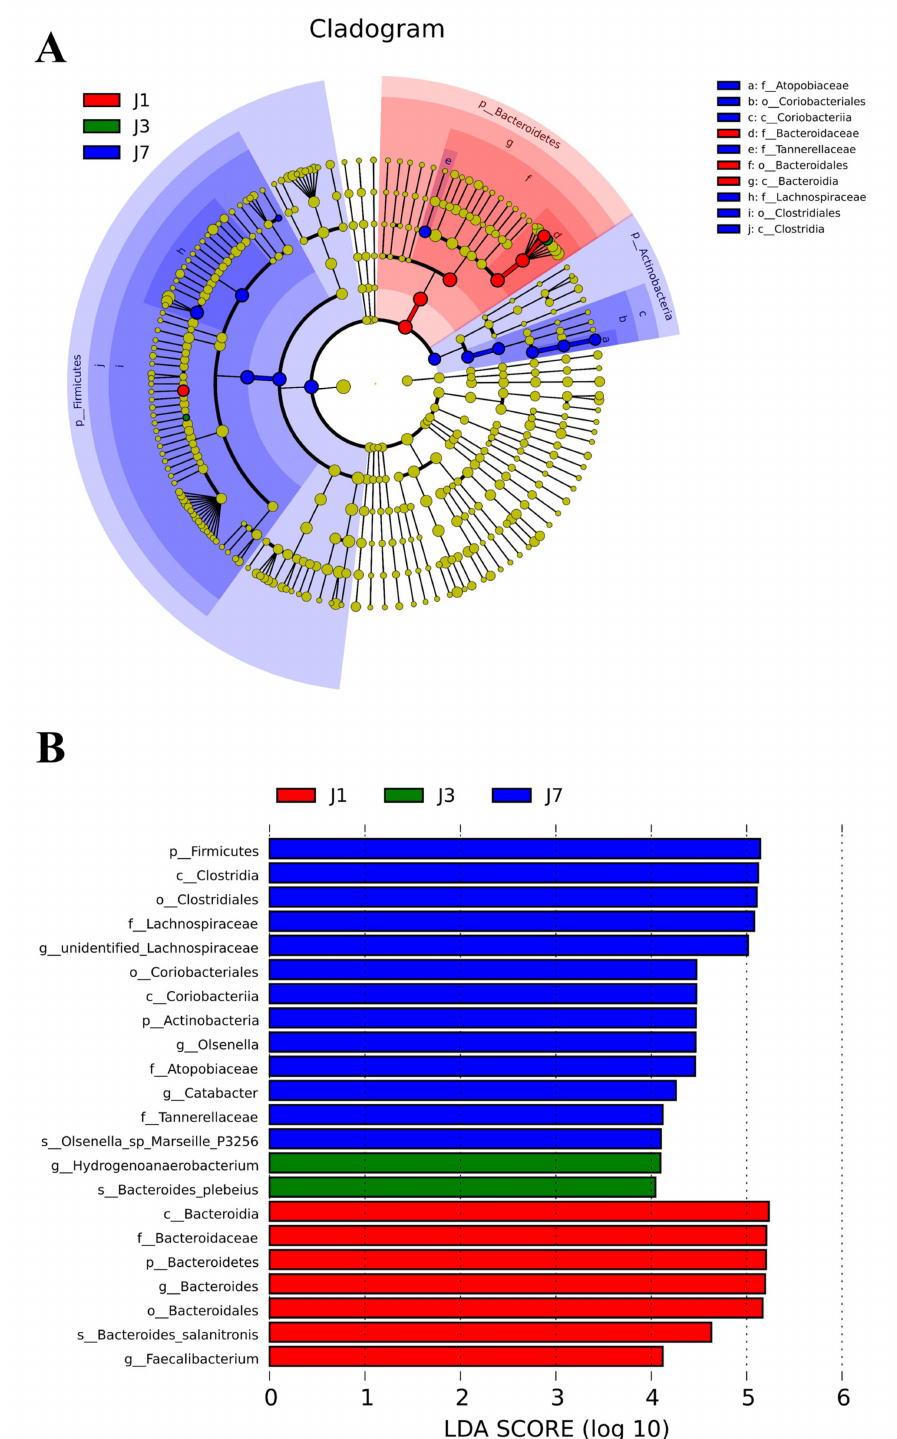
Figure 3. Linear discriminant analysis (LDA) combined with effect size (LEfSe) identified the most diverse groups in chicken cecal flora. ( A ) Taxonomic lineage plots were obtained from LEfSe analysis of 16S rRNA sequencing. Biomarker groups are represented by colored circles and shaded areas. The diameter of each circle is related to the abundance of taxa in the community. ( B ) Only the taxa met the significance threshold >4 for the linear discriminant analysis. J1 = CON, fed with the basal diet ad libitum; J3 = 80% FI, fed with 80% feed intake of the CON; J7 = 70% ME, fed with 70% metabolizable energy of the